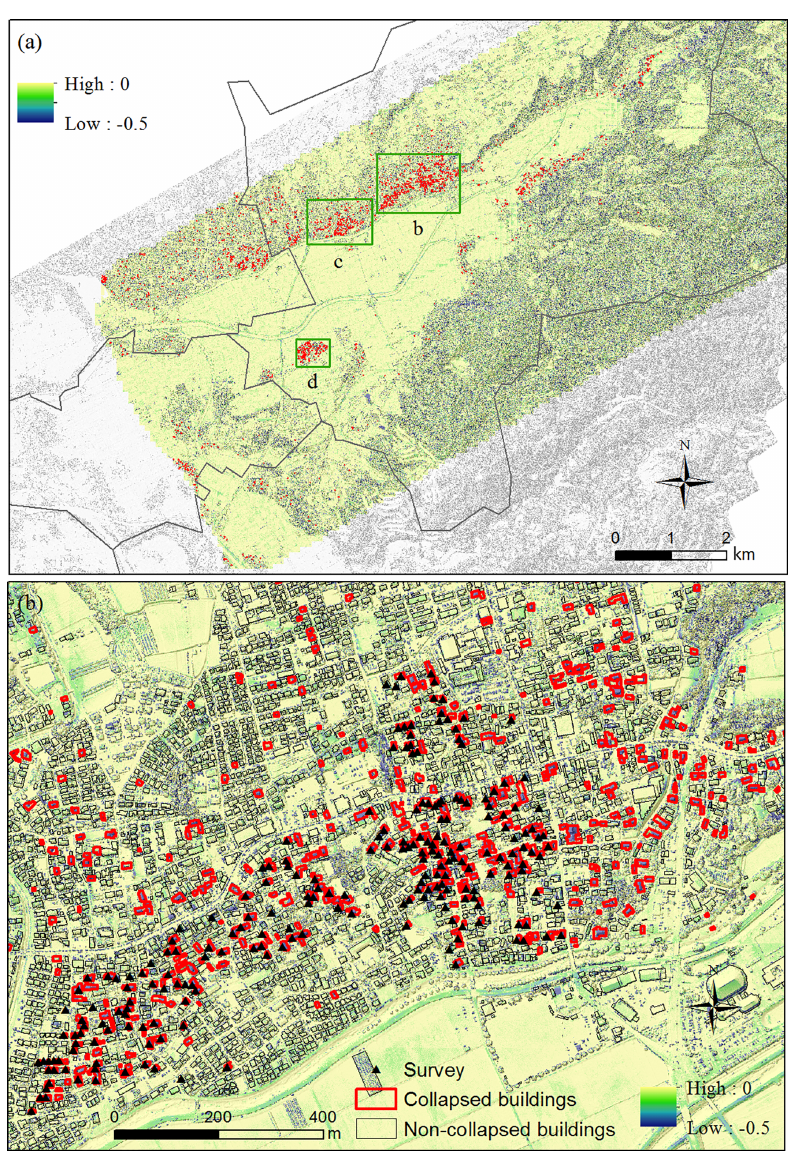
Figure 14. (a) A map showing the distribution of collapsed ( (cid:49)H< − 0 . 5m) buildings, shown as red polygons, in the study area. The pixel color represents the difference in elevation between the BDSM and ADSM. The green squares show the locations of areas shown in panel (b) and Fig. 15. Close-up view of area (b) in which the collapsed buildings were concentrated. The black triangles show the D5 buildings from Yamada et al.